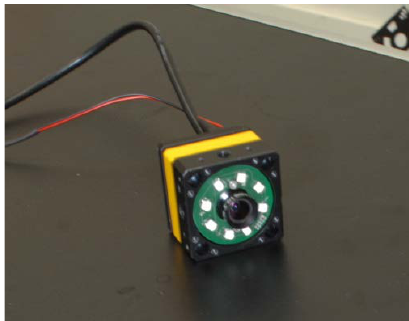
Figure 3. USB industrial camera with LED ring